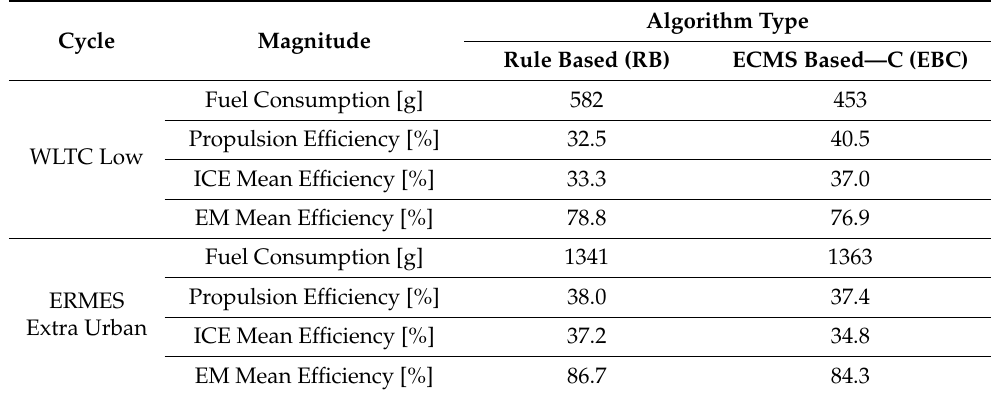
Table 7. Consumption and mean efficiency values of the main powertrain components for WLTC Low and ERMES Extra Urban in the case of Rule Based (RB) and ECMS Based—C (EBC) algorithms. Algorithm Type Cycle Magnitude Rule Based (RB) ECMS Based—C